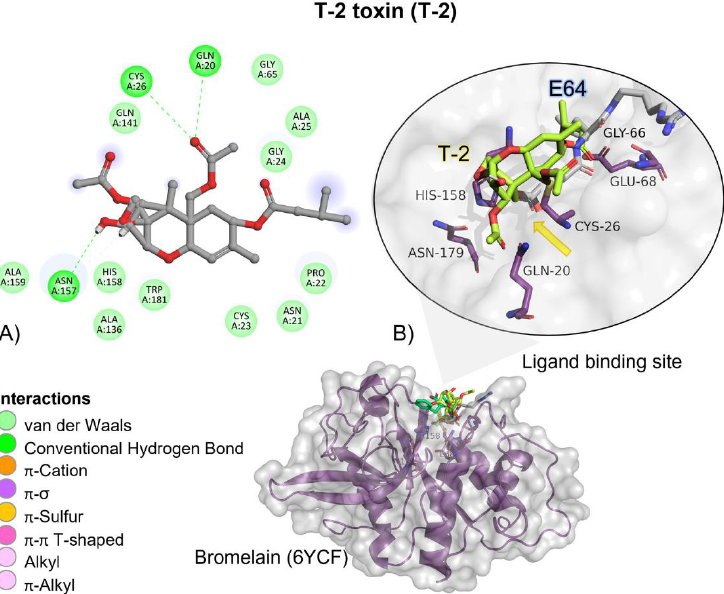
Figure 3. T-2 toxin — bromelain interactions. ( A ) Detailed view showing the interactions of the main different amino acid residues within the binding pocket of bromelain with the T-2 toxin ligand. ( B ) Panoramic view of the reference (E64) and the tested T-2 toxin ligands within the binding pocket of bromelain. Comparison between the docked pose of the tested and the reference ligand within the bromelain binding pocket. The yellow arrow indicates the proximity between the bromelain catalytic triad and the T-2 toxin.